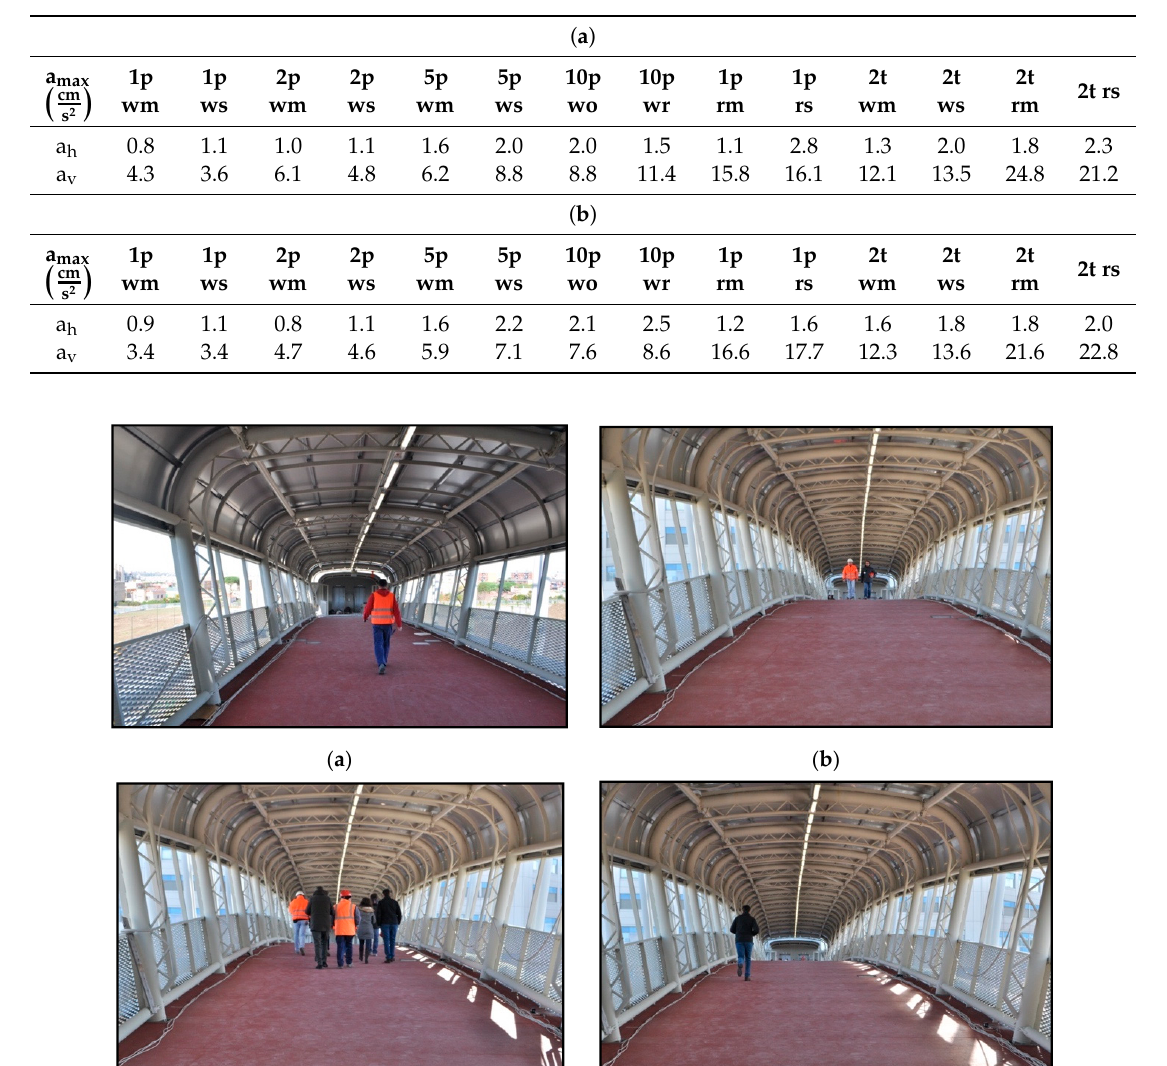
Table 6. (a) “Ospedale del Mare” footbridge: maximum recorded acceleration (a max ) in horizontal (a h ) and vertical (a v ) direction under di ff erent pedestrian-induced loadings, first passage. (b) “Ospedale del Mare” footbridge: maximum recorded acceleration (a max ) in horizontal (a h ) and vertical (a v ) direction under di ff erent pedestrian-induced loadings, second passage.